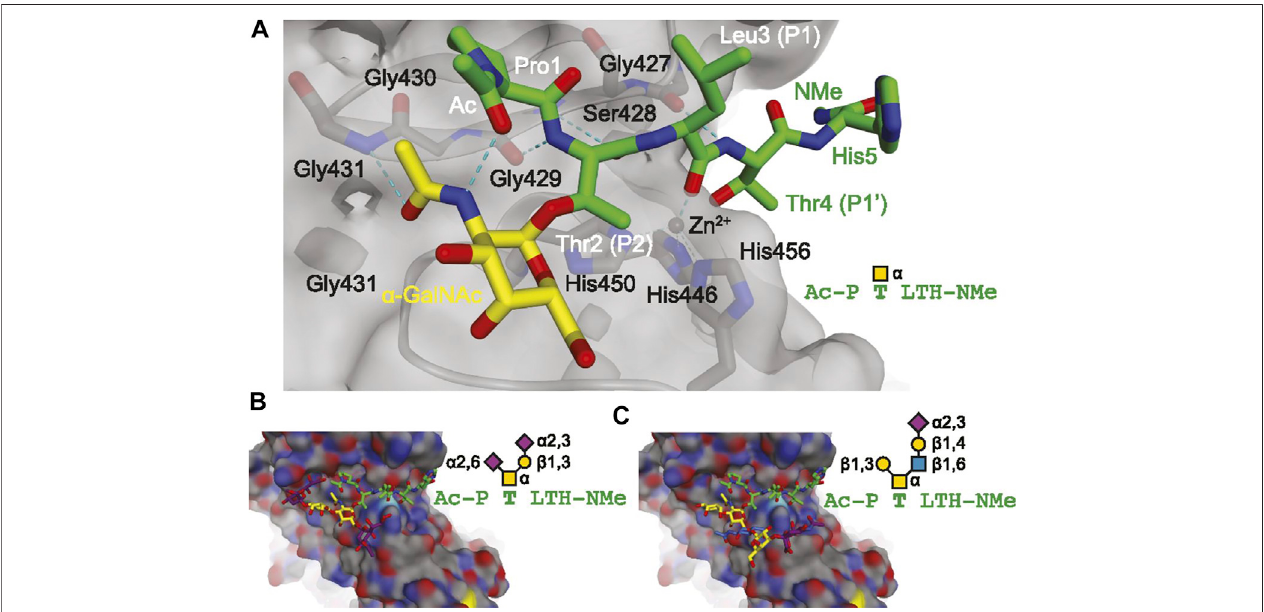
FIGURE 2 | Molecular modeling showing the docking of model glycopeptides ( A , AcP( α -GalNAc)TLTH-NMe; (B) , AcP(disialyl core 1)TLTH-NMe; (C) , Ac-P(sialyl core2)TLTH-NMe)withthemucin-selectiveproteaseStcEfrom E.coli. ReproducedfromMalaker,S.A.,Pedram,K.,Ferracane,M.J.,Bensing,B.A.,Krishnan,V.,Pett, C., et al. (2019). The mucin-selective protease StcE enables molecular and functional analysis of human cancer-associated mucins. Proc. Natl. Acad. Sci. U.S.A. 116, 7278 – 7287. doi: 10.1073/pnas.1813020116 under the PNAS license to publish.